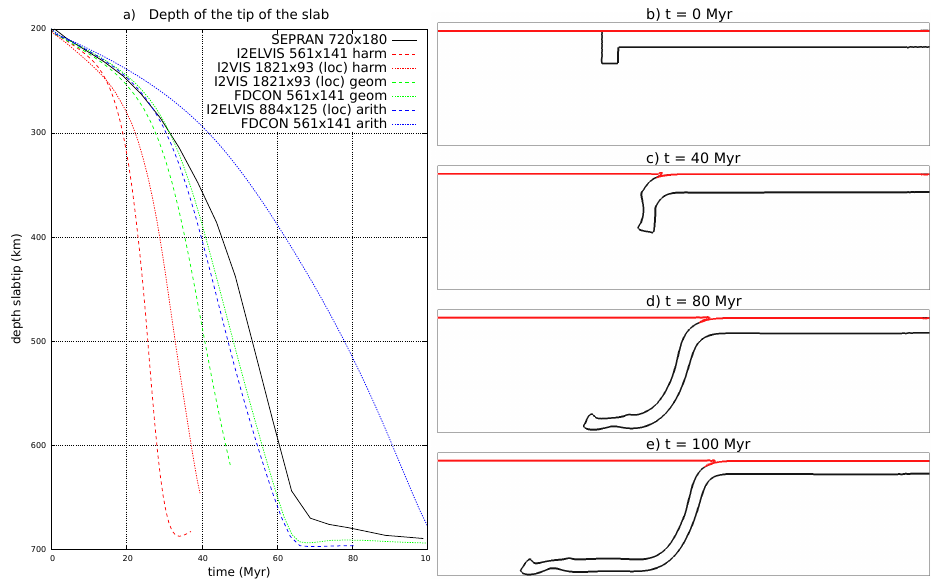
Figure 6. (a) Depth of slab tip vs. time. (b) through (e) snapshots in time of the slab. The red line indicates the location of the zero isocontour of the level set function tracking the surface and the black line indicates the zero isocontour of the level set function tracking the slab.